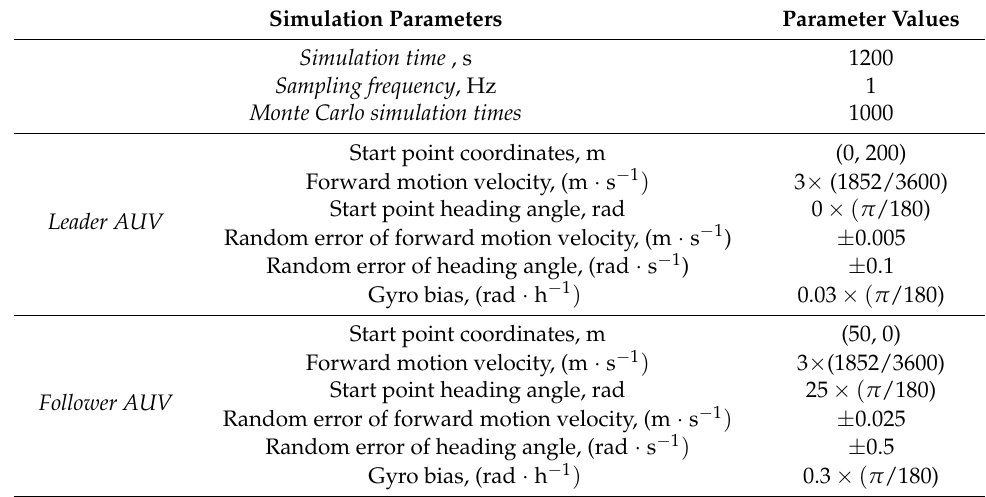
Table 1. Simulation parameter